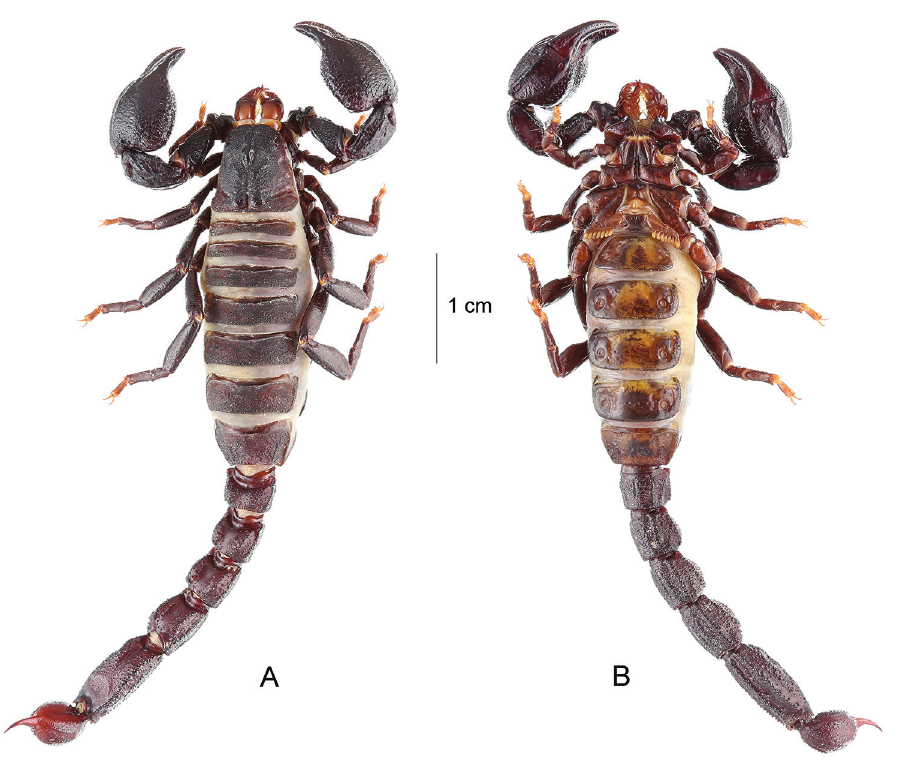
Figure 7. Teuthraustes kuryi sp. n. Female holotype. A–B Habitus, dorsal A and ventral B aspects. spicuous; VII acarinate with granulations; pectinal tooth count 7–7 in both females, holotype and paratype, fulcra vestigial. Metasoma: segments I and II wider than long; metasomal tegument on segments I to IV strongly granulated including dorsal aspect; segment V with some spinoid granulations ventrally; carinae on segments I–V strongly developed; ventral present on all segments; telson strongly granulated; aculeus shorter than vesicle. Chelicerae: dentition typical of the family Chactidae (Vachon 1963), and with dense setation ventrally and internally. Pedipalps: femur with dorsal internal, dorsal external and ventral internal carinae strongly marked; ventral external carina vestigial; dorsal, ventral and internal aspects granulated; patella granulated with well- marked carinae; chela strongly granulated and with most carinae well-marked; dentate margins on movable and fixed fingers with 5–6 rows of granules; trichobothriotaxy of type C; neobothriotaxic ‘majorante’ (Vachon 1974). Legs: tarsi with short setae disposed in a single